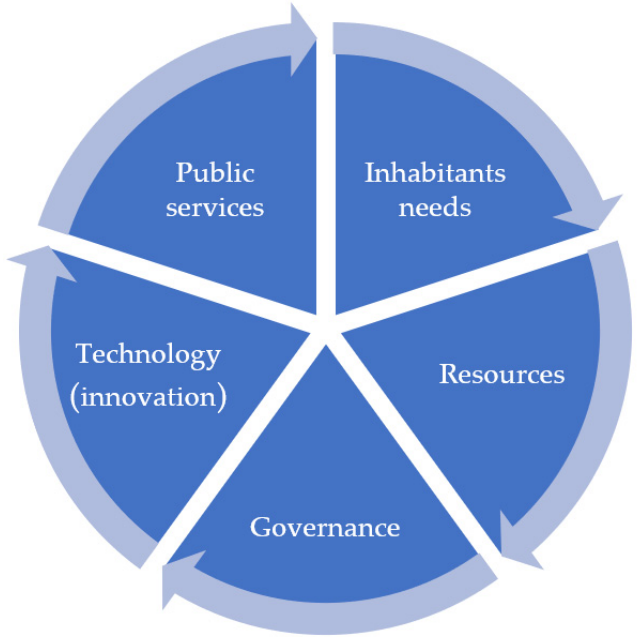
Figure 2. The factors involved in the model of smart village.